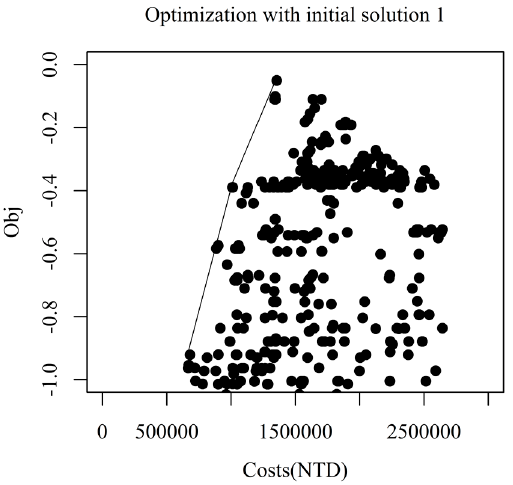
Figure 4. Relation between low impact development (LID) cost and objective function